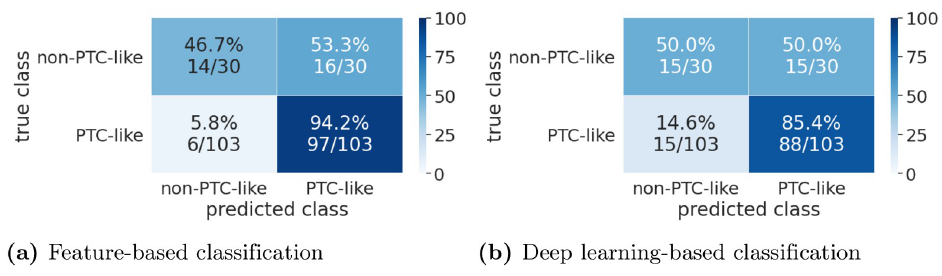
Fig 7. Confusion matrices for the Nikiforov dataset.